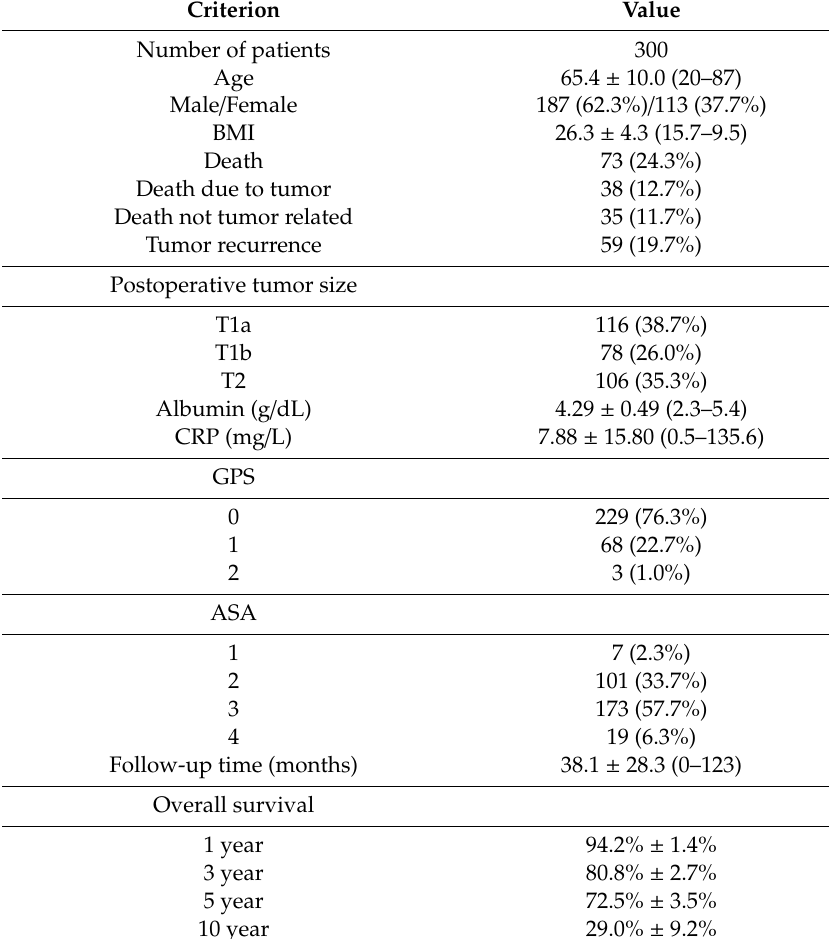
Table 1. Compact summary of the oncological aspects of 300 patients undergoing curative surgery for protein; GPS, Glasgow Prognostic Score; ASA, American Society of Anesthesiologists physical status classification